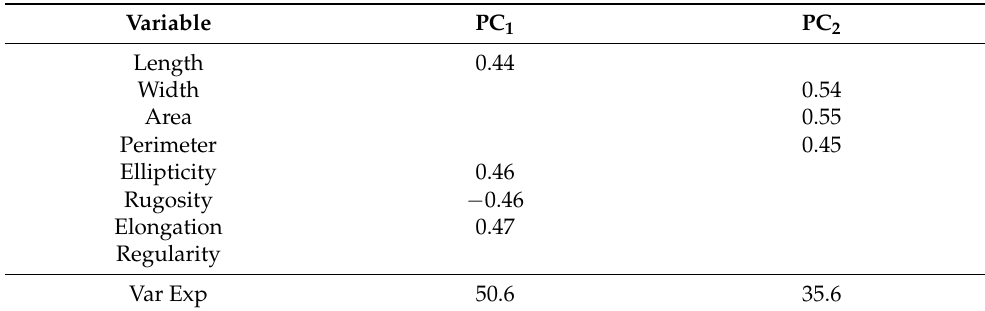
Figure 2. Box plot of distribution of litter size and other litter variables for the different boars. Each box contains the central 50% of the observations, and the whisker contains the central 95%. a–f Boxes labelled with different letters indicate differences between boars. p < 0.05. Table 3. Eigenvectors of principal components (PCs) * for the morphometric variables of boar sperm size and head